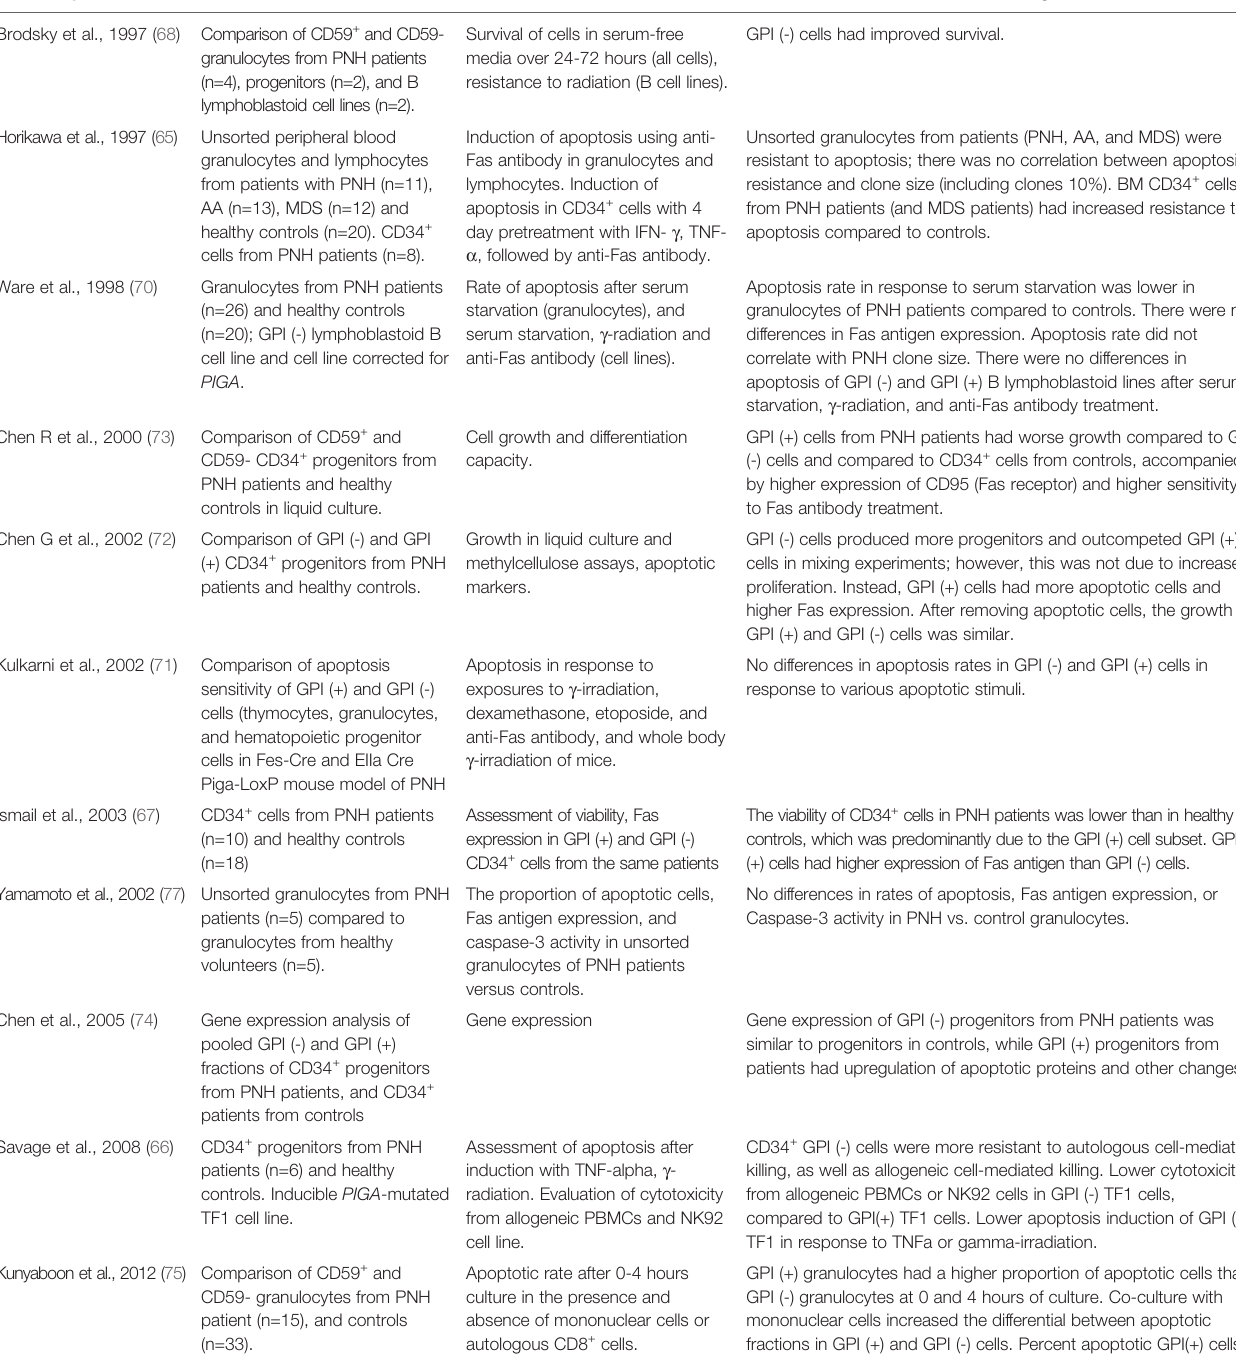
TABLE 3 | Summary of studies evaluating response to apoptosis by PNH cells. Model Condition Tested Main